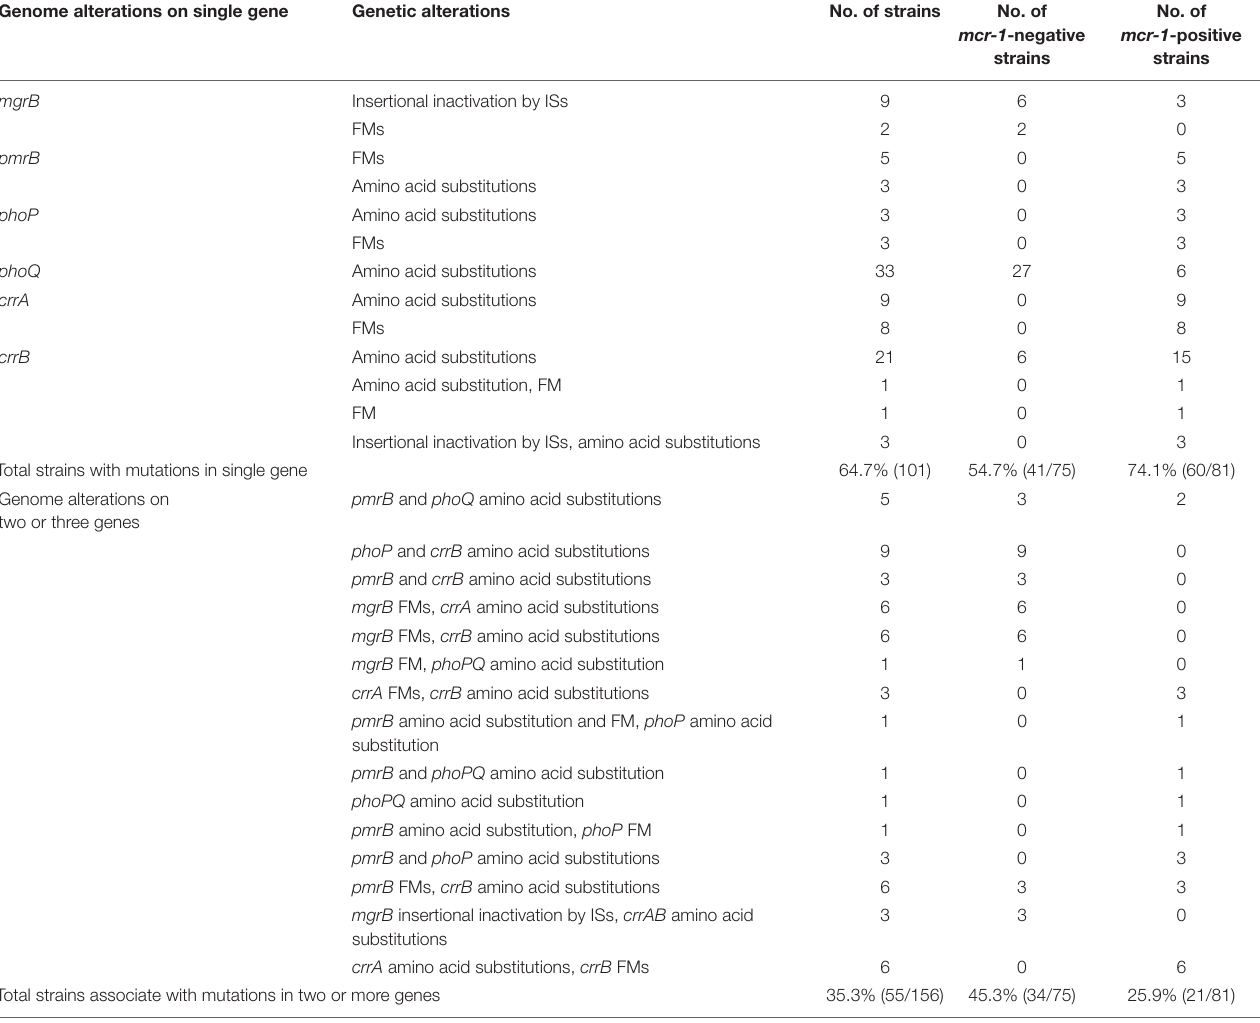
TABLE 1 | Number of K. pneumoniae derivatives with genomic mutation(s) in colistin resistance genes after stepwise induction. Genome alterations on single gene Genetic